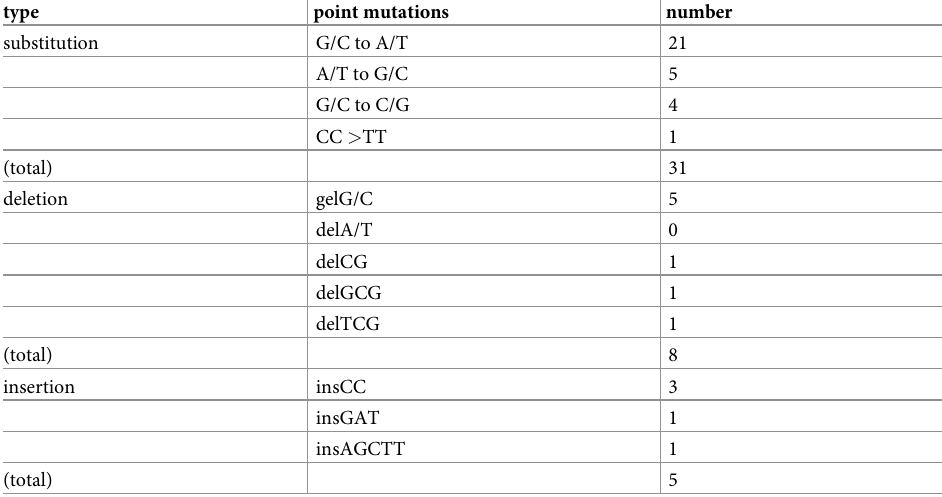
Table 3. Type of point mutations found in the RED-deficient mutants of S . coelicolor JCM4020 by carbon ion